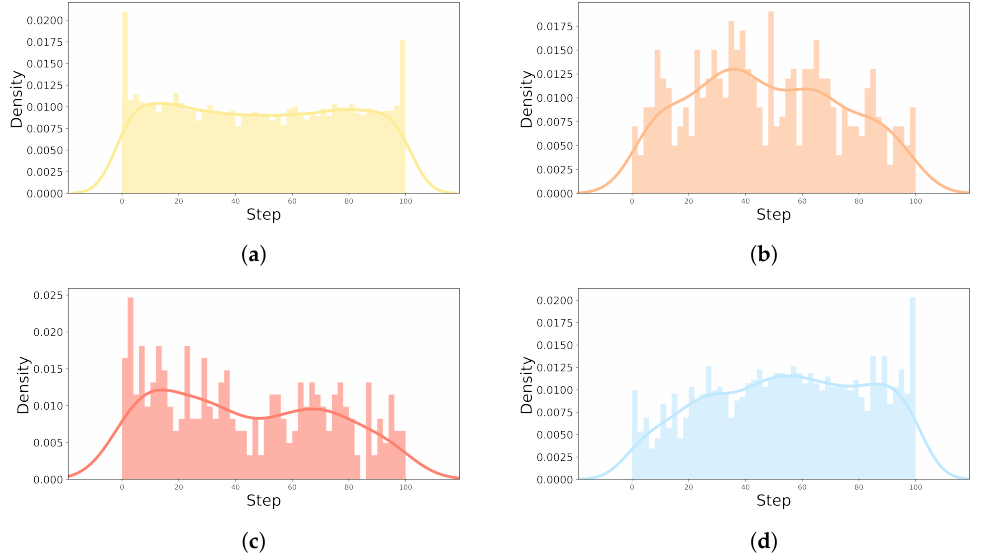
Figure 6. Distribution of self-reported emotion labels in real-world driving. ( a ) Happy|Neutral; ( b ) Excited|Surprised; ( c ) Angry|Disgusting; ( d )